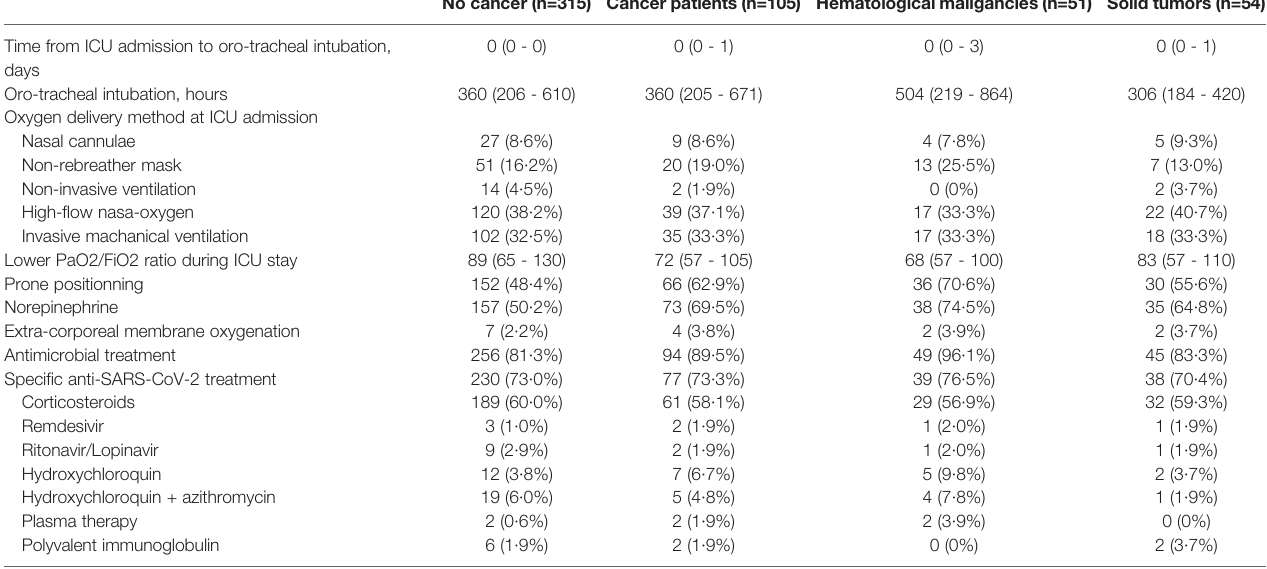
TABLE 3 | Management of patients during ICU stay.